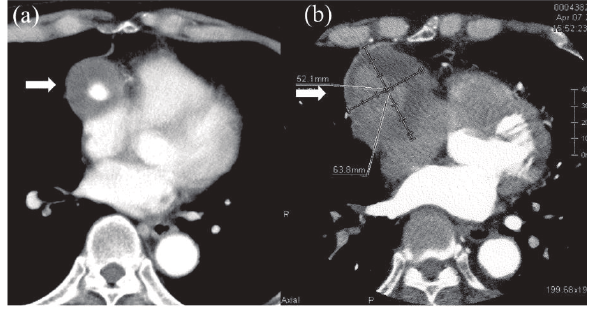
Figure 2: Vein graft aneurysm progression over 4